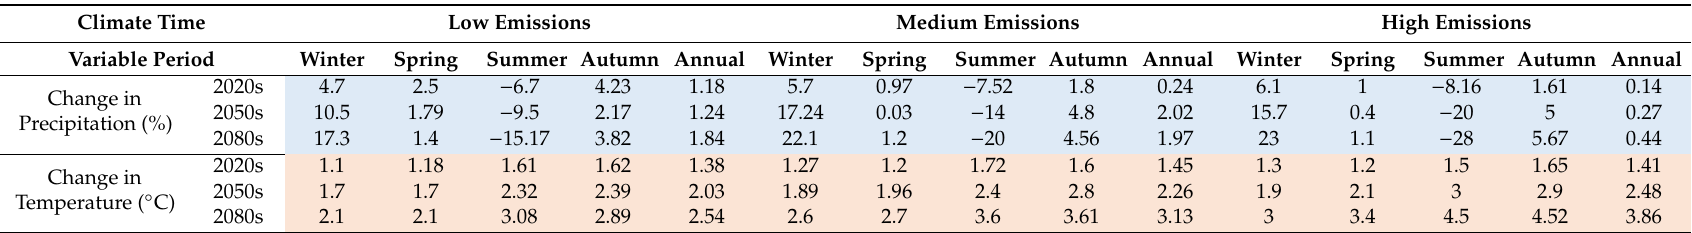
Table 1. Probabilistic changes in temperature and precipitation for the Frome catchment under UKCP09 climate change scenarios under low, medium and high emission scenarios for the 2020s, 2050s and 2080s (30-years’ time periods) using the Joint Probability